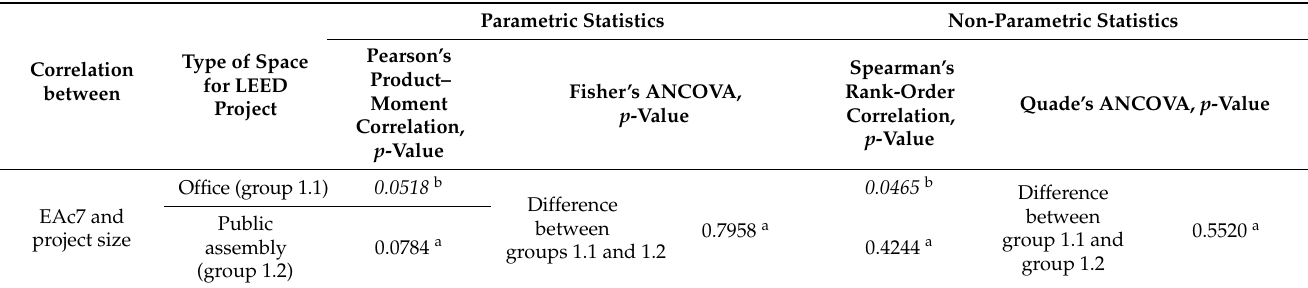
Table 4. Case 1: comparison of EAc7 (Optimize Energy Performance) credit achievement of groups 1.1 and 1.2 when considering project size in LEED-NC v4 certified